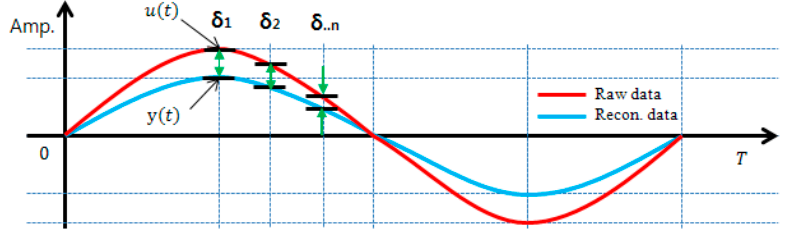
Figure 3. Concept of reconstruction error (RE).